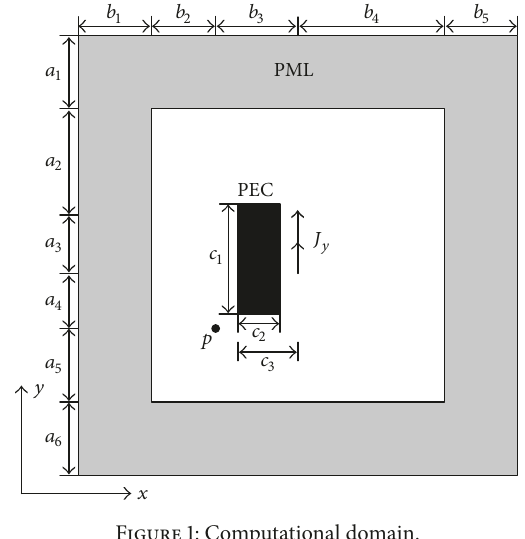
Figure 1: Computational